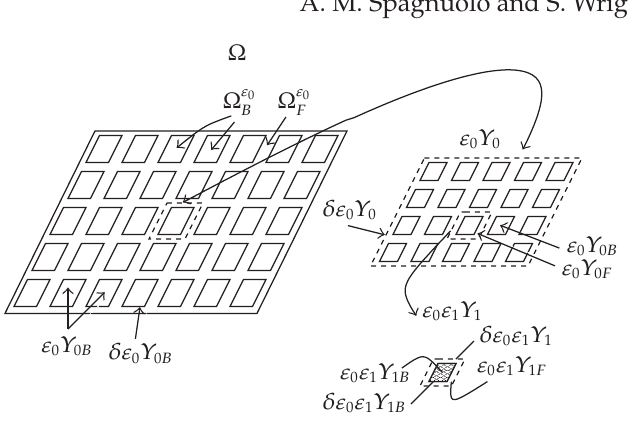
Figure 2.1 . The parts of the